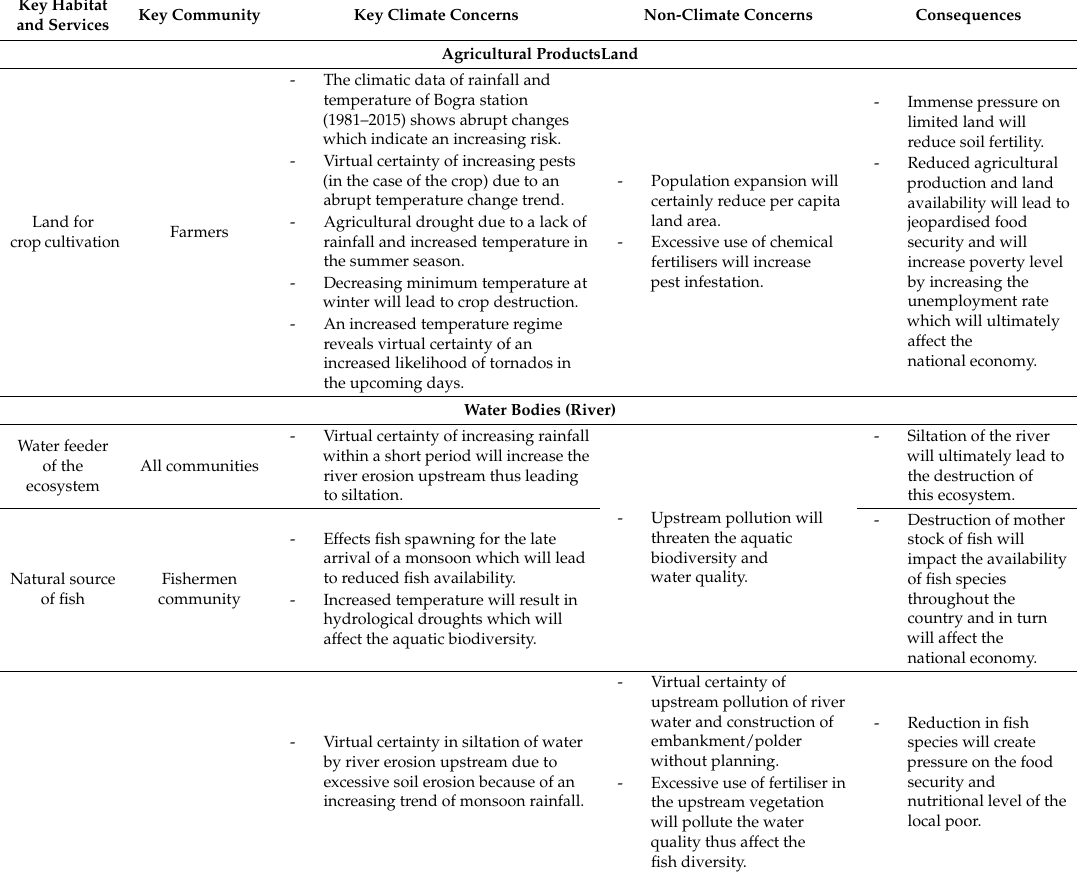
Table 4. Assessing the consequences of changing climatic conditions and possible